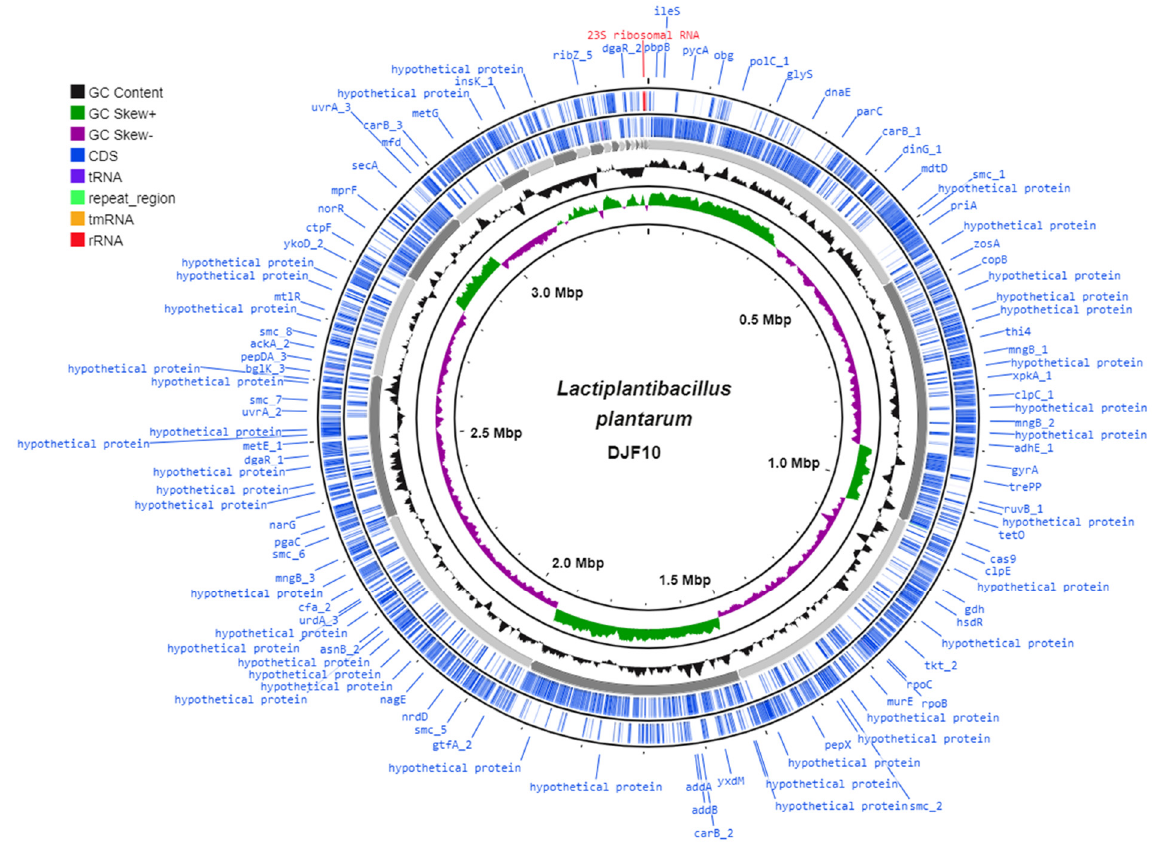
Figure 1. Circular map of the Lactiplantibacillus plantarum DJF10 genome visualized using the CGView tool. Genomic features marked from the outer to the inner circle as follows, circle 1 and 2 illustrate Prokka annotated forward and reverse CDS (coding sequences), respectively, with tRNA, rRNA, tmRNA and Cas elements; circle 3 represents GC content; circle 4 shows the GC skew (G-C)/(G+C), and circle 5 shows the genome size (3,385,113 bp).